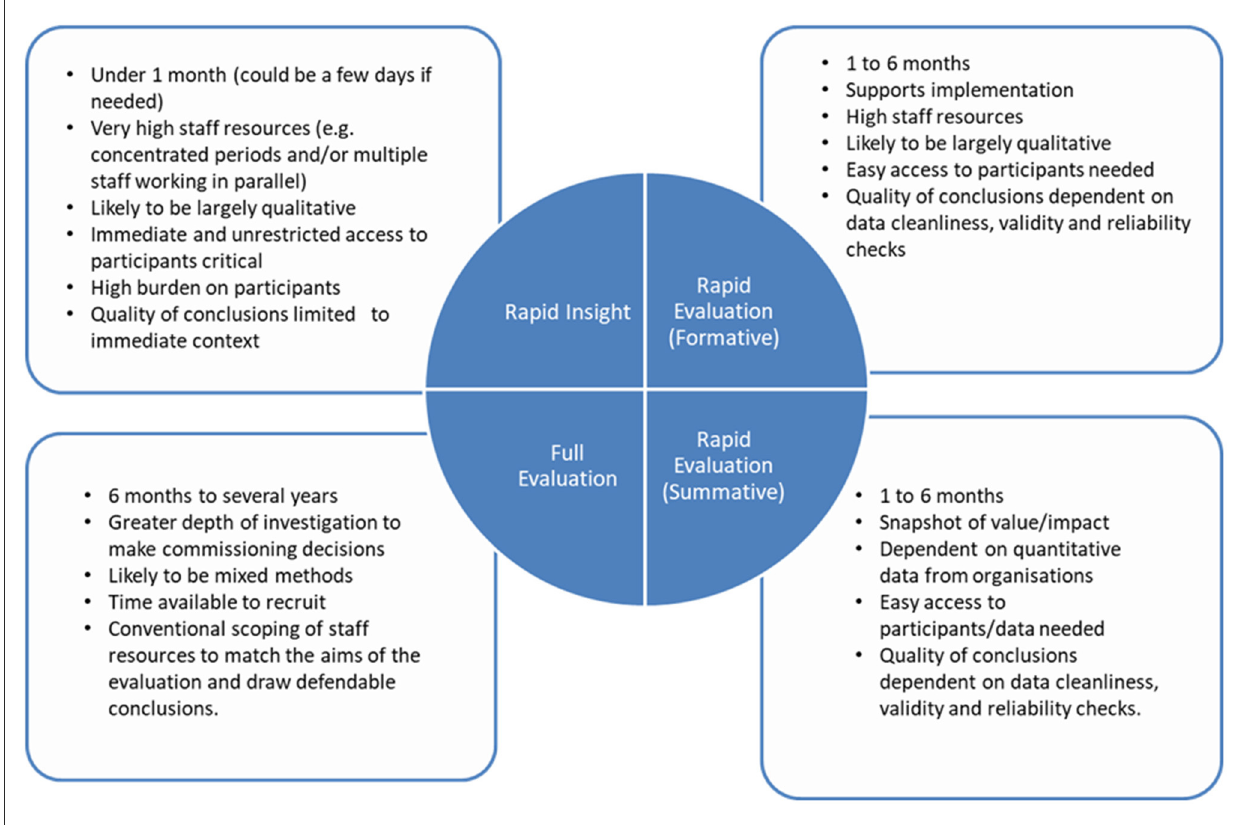
FIGURE1 A basic positioning of Rapid Insight within the evaluation